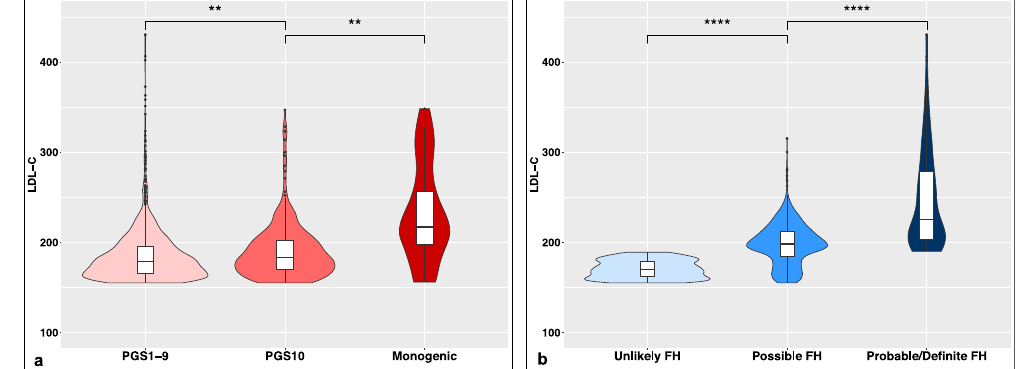
Fig. 2 Distribution of LDL-C levels in the study population. a Distribution of LDL-C levels based on genotype, and b based on phenotype. The boxplots are embedded in the density plots. The central line represents median, box limits represent upper and lower quartiles, the vertical lines represent 1.5× quartile range, and points represent outliers. In the left plot, PGS1 – 9 indicates those with the PGS in the 1st to 9th decile. PGS10 represents those with the PGS in the top decile (polygenic etiology of hypercholesterolemia) and Monogenic represents those with a P/LP variant in LDLR, APOB or PCSK9 . On the right side, DLCN criteria are used for categorizing cases as Unlikely FH: DLCN <3, Possible FH: 3 ≤ DLCN <6, and Probable/De fi nite FH: DLCN ≥ 6. FH familial hypercholesterolemia, LDL-C low-density lipoprotein cholesterol, PGS polygenic score (number refers to PGS decile). t -test is used for comparison. * P -value < 0.05, ** P -value < 0.01, *** P -value < 0.001, **** P -value < 0.0001 and ns = non-signi fi